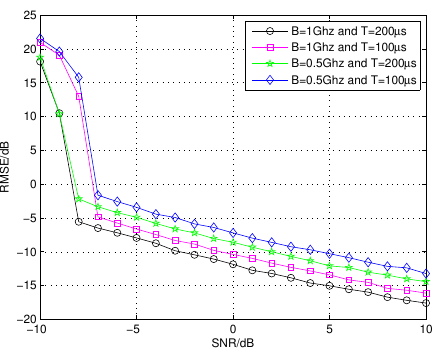
Figure 9. The performances of the CCAE with different values of bandwidth and pulse durations in different SNR conditions.